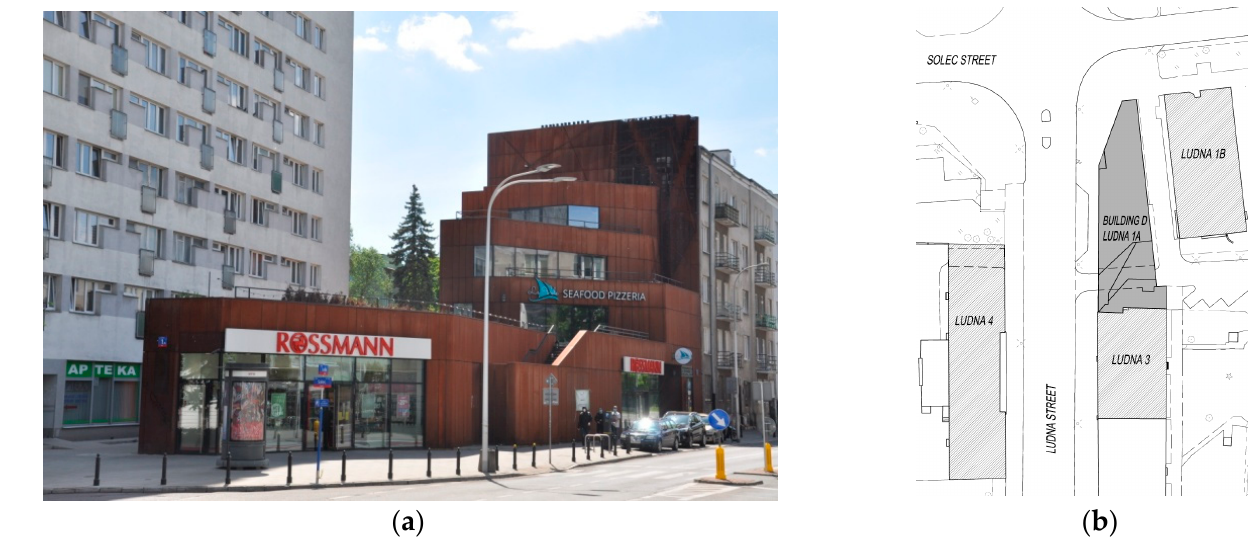
Figure 1. Building D with adjacent buildings ( a ) and location sketch ( b ).